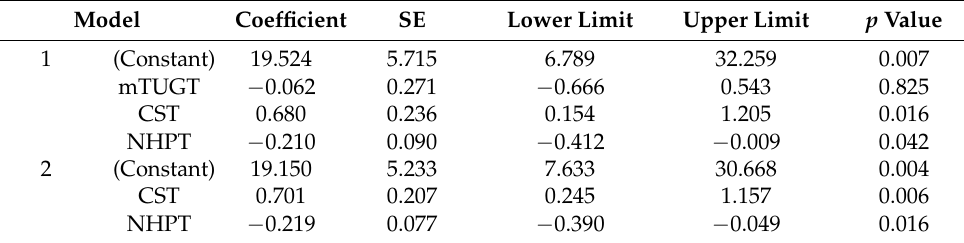
Table 6. Model coefficients (stepwise